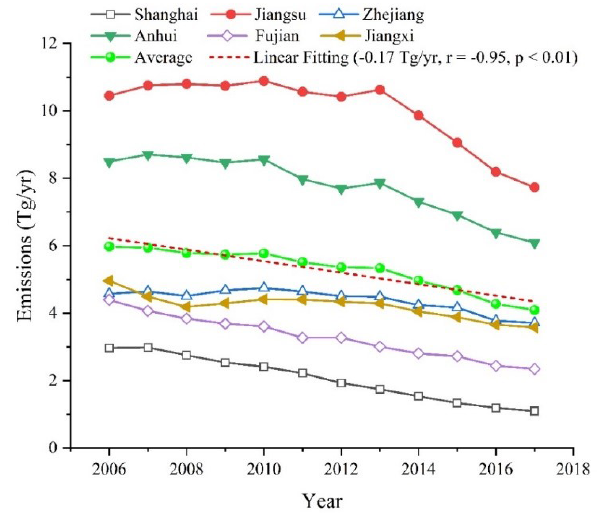
Figure 11. CO emissions from 2006 to 2017 in the provinces and cities surrounding LAN station and linear fitting of the av- erage annual CO emissions of the six provinces and cities. Data source: http://meicmodel.org/dataset-mix.html (last access: 1 Octo- ber